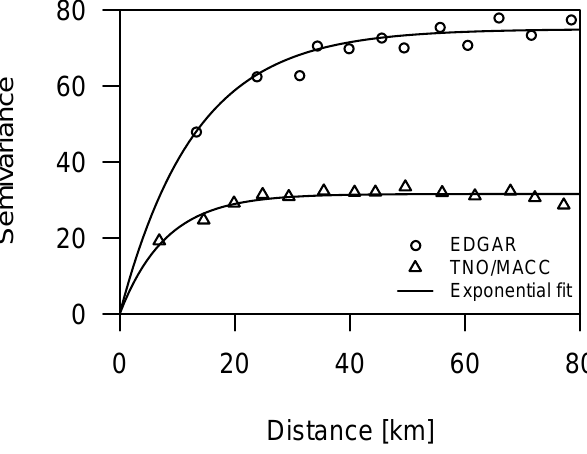
Fig. 5. Semivariogram of the differences between the EDGAR v4.2 and TNO/MACC inventories and our inventory. Also shown are ex- ponential fits to the data (see text for further